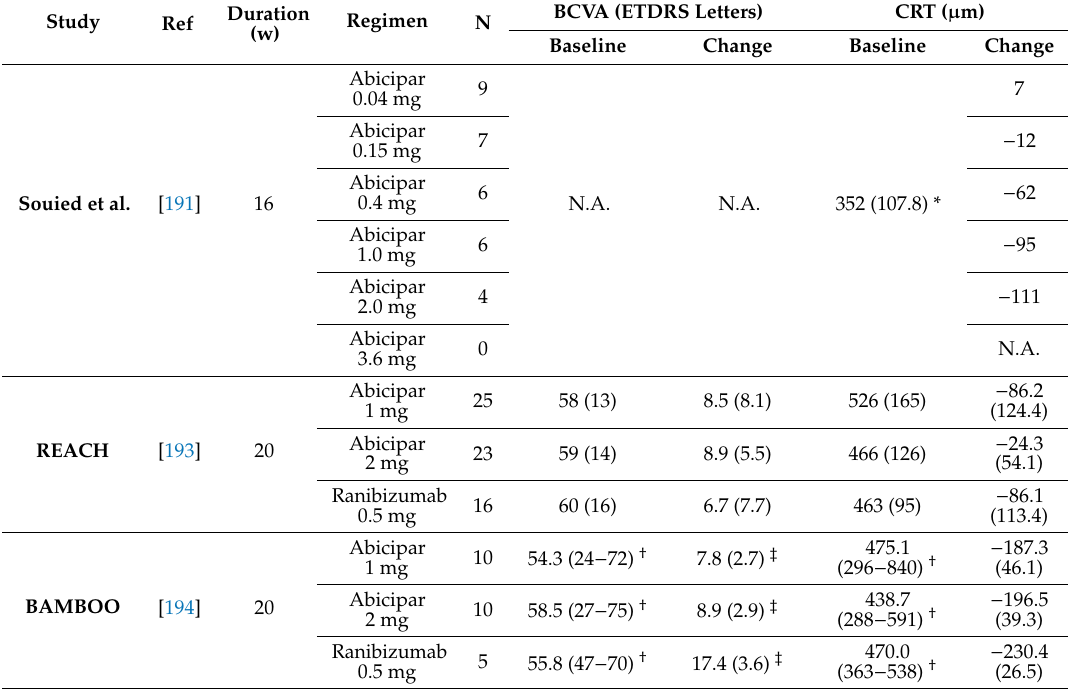
Table 9. Overview of the functional and anatomic results of